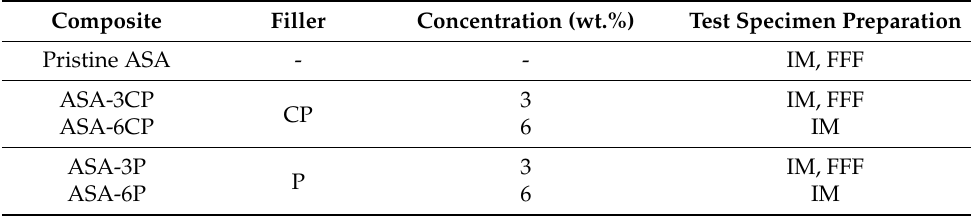
Table 1. Prepared composites and synthesis conditions.